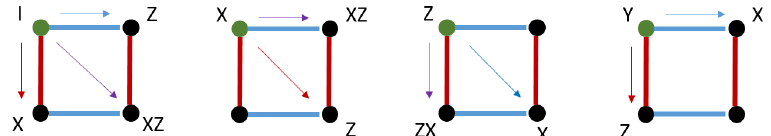
Figure 11. Any Pauli operator (including the identity) can be pushed across the tensor by switching the original state | ψ i to | ψ 0 i